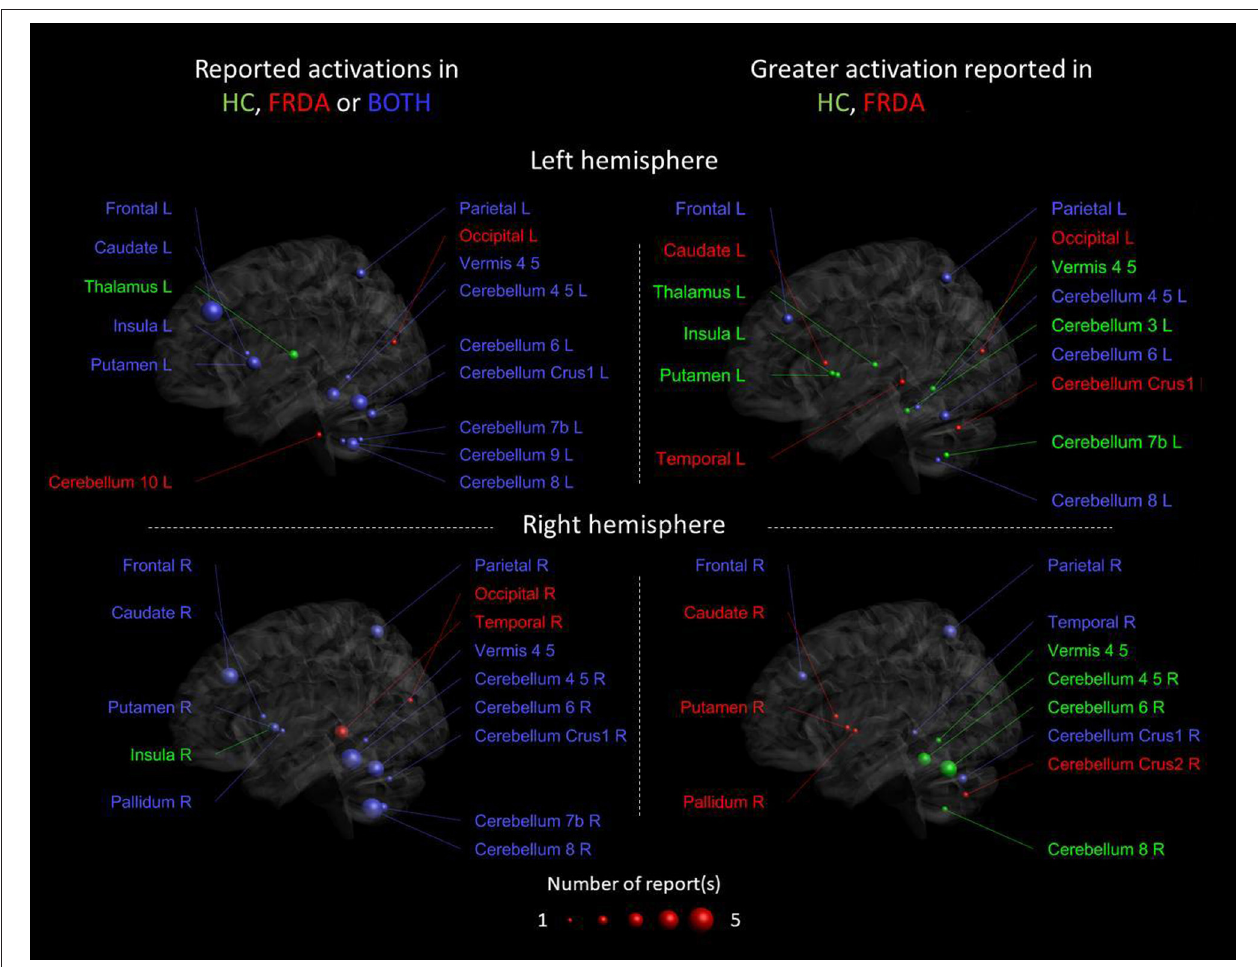
FIGURE 2 | Cerebral and cerebellar areas reported as activated in the studies that performed a motor task fMRI. The colors of the nodes reflect activation in the respective groups as reported from each study: green [healthy controls (HCs)], red (FRDA), and blue (both groups). The panels on the left show the reported activated areas for each group or both groups, the panels on the right show the differential activation consistently reported when FRDA was compared to controls. The blue areas in the right panels are the areas in which the reports are conflicting. The size of the nodes reflects the number of papers reporting activation in a particular area, reported for each right and left